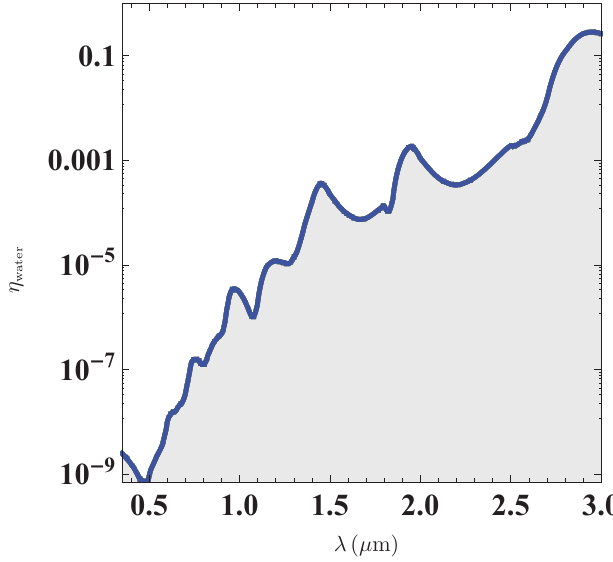
Figure 1. Imaginary part of the refractive index for water. According to Equation (11), the curve also represents the ultimate detection limit for refractometry in an aqueous environment. Data is reproduced from